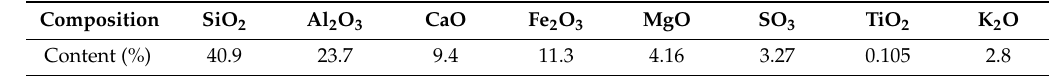
Table 5. Chemical Composition and Physical Indexes of silica